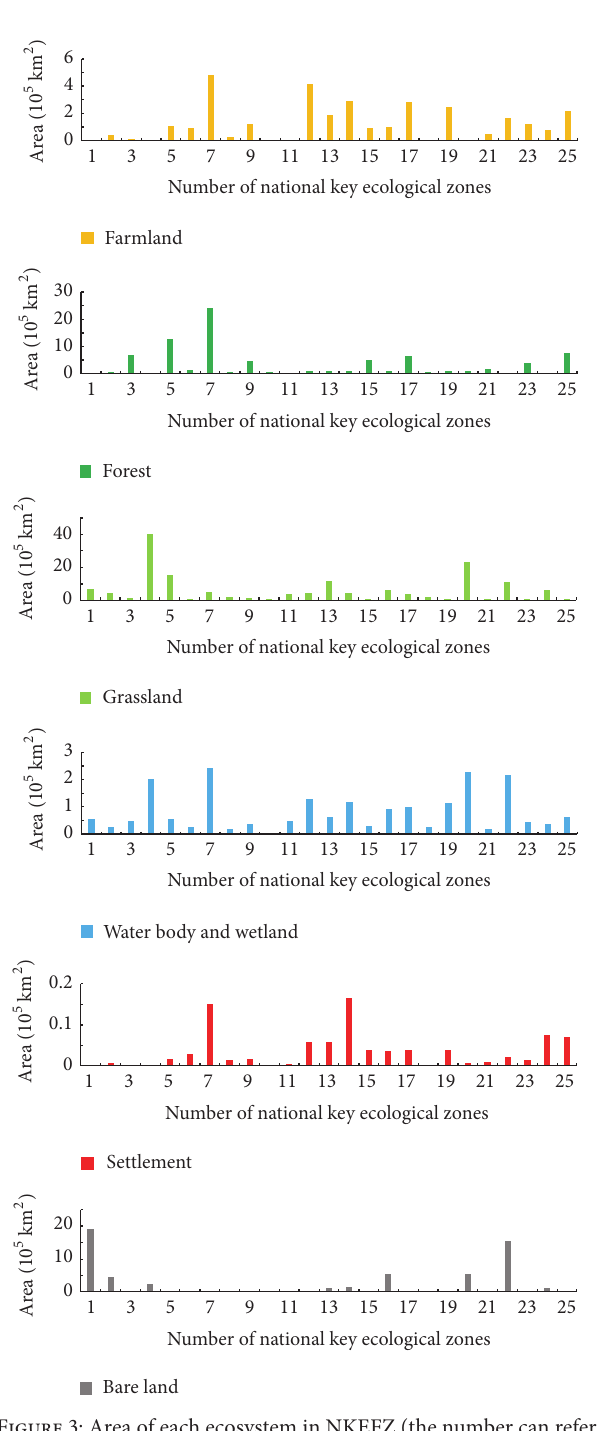
Figure 3: Area of each ecosystem in NKEFZ (the number can refer to Figure 1).